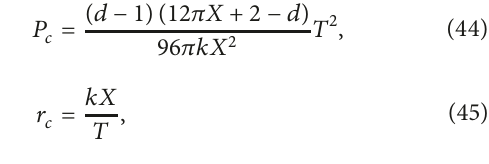
and the classical “swallow tail” characterizing the small/large black holes phase transition as shown in 𝐺 − 𝑃 diagrams of Figure 7. As for the case of six dimensions, it is easy to find 3 𝑃/𝜕𝑟 3 = 0 . Therefore, one that the critical point leads to 𝜕 + can not observe the 𝑃 − 𝑟 + oscillatory behavior as shown in Figure 4, and no first-order phase transition exists as shown in Figure